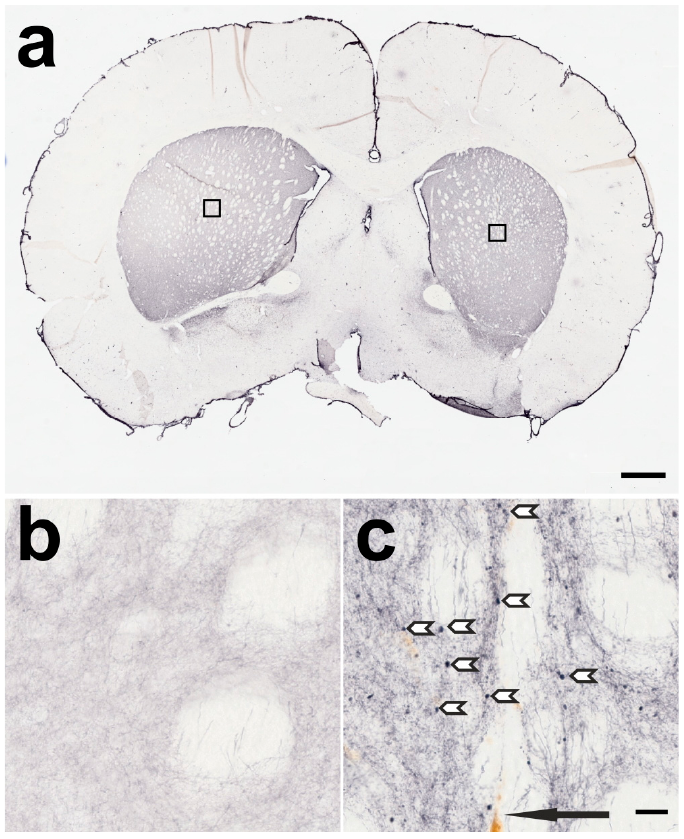
Figure 3. A frontal section through the telencephalon of a rat treated with 1 ng BoNT-A in the right CPu one month earlier, immunohistochemically stained against TH. ( a ) An overview of the frontal section, and ( b ) the enlarged area of the left (untreated) CPu marked with a box above on the left side in ( a ). In ( c ), a comparable area of the right (BoNT-A-treated) CPu is enlarged. TH-positive BiVs (BoNT-A-induced varicosities) are marked with white arrowheads. The black arrow points to the injection channel with brownish colored macrophages. The scale bar in ( a ) corresponds to 1 mm, the bar in ( c ) corresponds to 20 µm and is valid for ( b , c ).